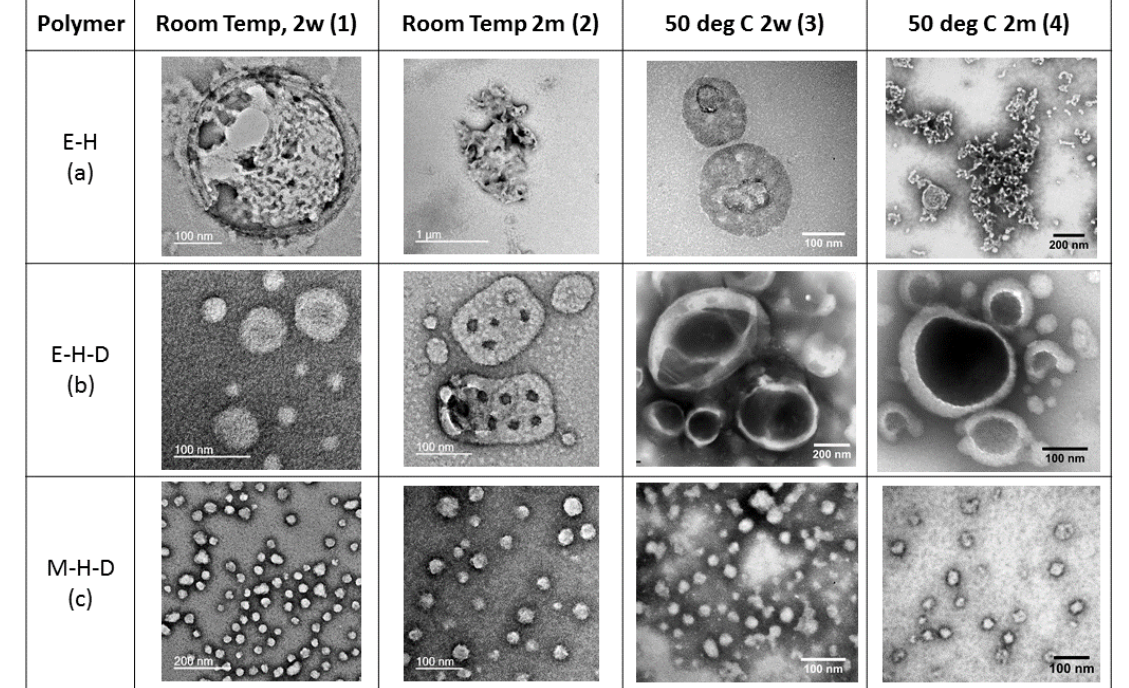
Figure 2. TEM images of the self-assembly structures of our block-copolymers: PEG-PHPMA (E-H, ( a )), PEG-PHPMA-PDPA (E-H-D, ( b )), and PMPC-PHPMA-PDPA (M-H-D, ( c )). Images were taken at different conditions, namely at room temperature after 2 weeks ( 1 ) and 2 months ( 2 ) as well as at 50 °C after 2 weeks ( 3 ) and 2 months ( 4 ).